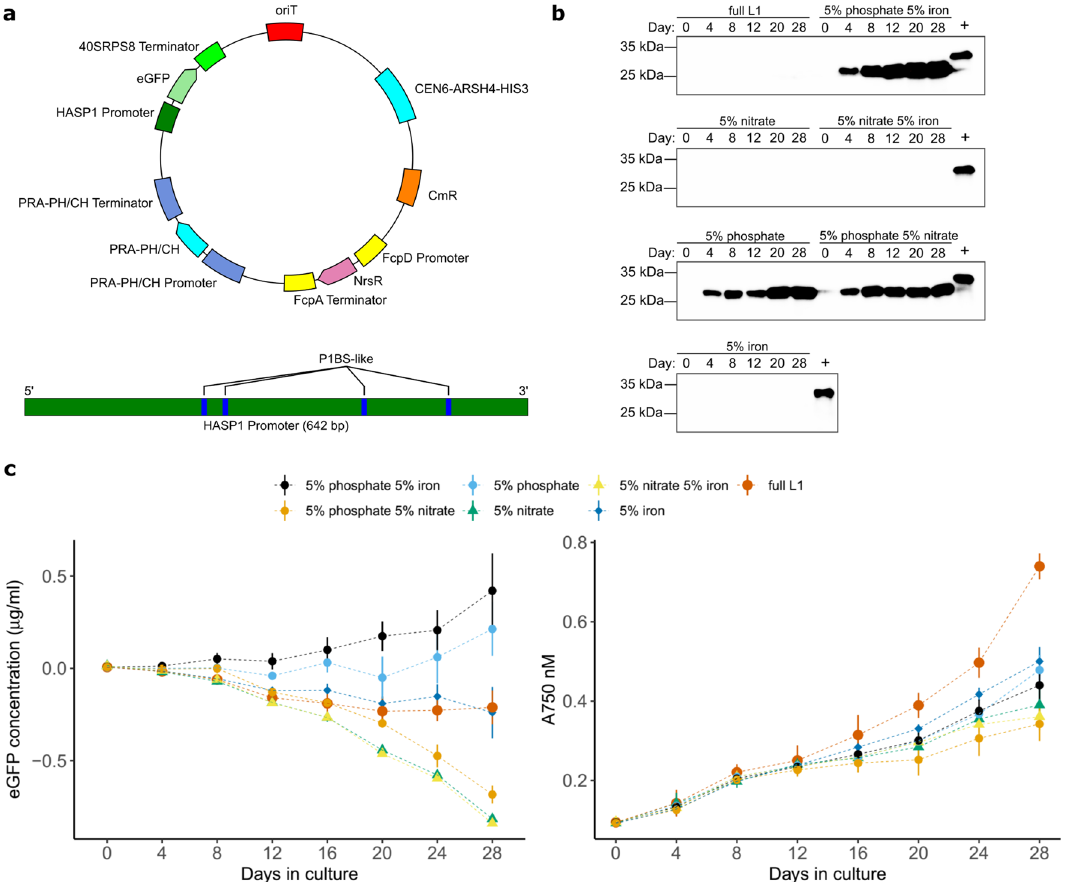
Figure 2. Phosphate-regulated expression of eGFP from the HASP1 promoter. ( a ) Schematic of the plasmid construct (top) and putative phosphate-regulatory motifs (P1BS-like) in the HASP1 promoter region (bottom). ( b ) Western blot with an anti-GFP antibody of whole cell extracts from pSS10 clone 3 grown in the different media conditions and sampled on the indicated days. The (+) control lane is a purchased 6X-histidine tagged GFP. eGFP expressed in our experiments is not 6X-histidine tagged. ( c ) Left panel, plot of eGFP concentration in culture supernatants measured over time under different media conditions for one clone of pSS10 (clone 3). Supernatant fluorescence values were subtracted from values taken from supernatants of wild-type P. tricornutum grown in parallel to correct for autofluorescence. Right panel, plot of absorbance at 750 nM over time for pSS10 grown in the indicated media. For both plots, data points are the mean of two replicate experiments each with three technical replicates. The whiskers represent the standard deviation. Uncropped gel images for panel ( b ) are shown in Supplementary Figures S14 and